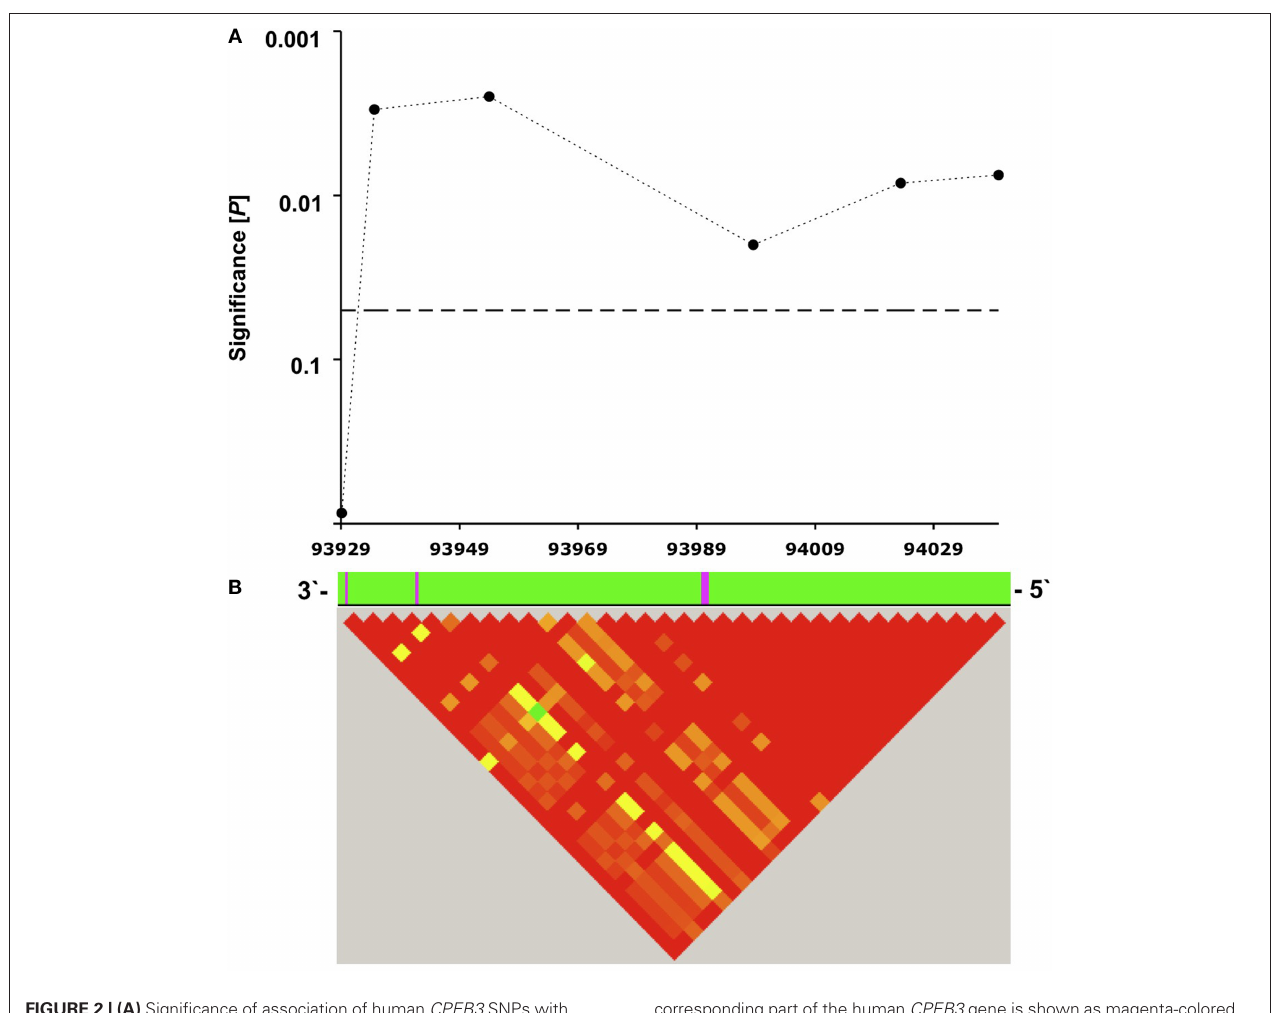
FIGURE 2 | (A) Signifi cance of association of human CPEB3 SNPs with episodic memory performance. Analyzed SNPs (3 ′ to 5 ′ direction): rs7071217, rs3781230, rs11186856, rs11186872, rs17107517, rs11186898. The dotted horizontal line indicates the 5% signifi cance level. The x -axis represents the chromosomal position of the SNPs in kilobases. The